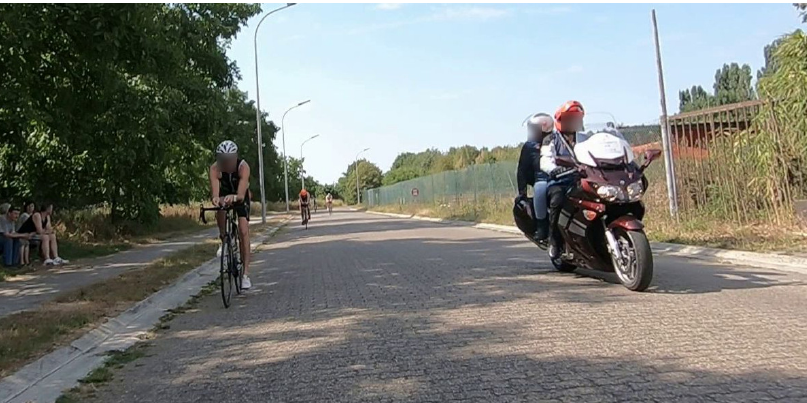
Figure 1. Typical drafting rule check in a triathlon race. A motorbike rides next to the athletes, and the referee performs a visual estimate of the distance between them. If the estimated distance is too small (e.g., smaller than 10 m) for an extended period (e.g., longer than 20 s), the drafting athlete receives a